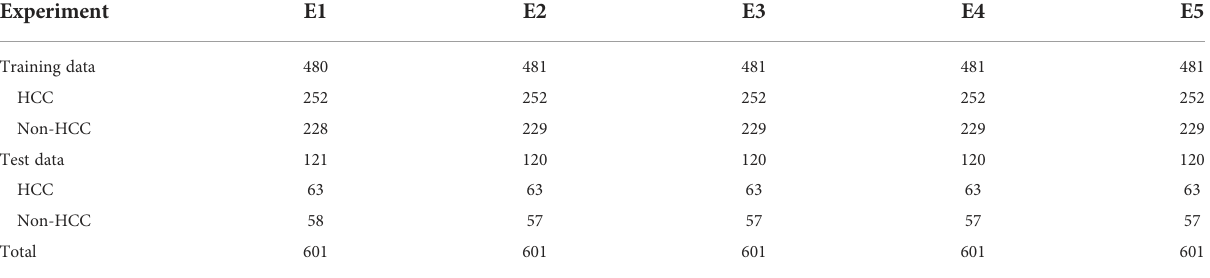
TABLE 2 Distribution of the fi vefold cross-validation